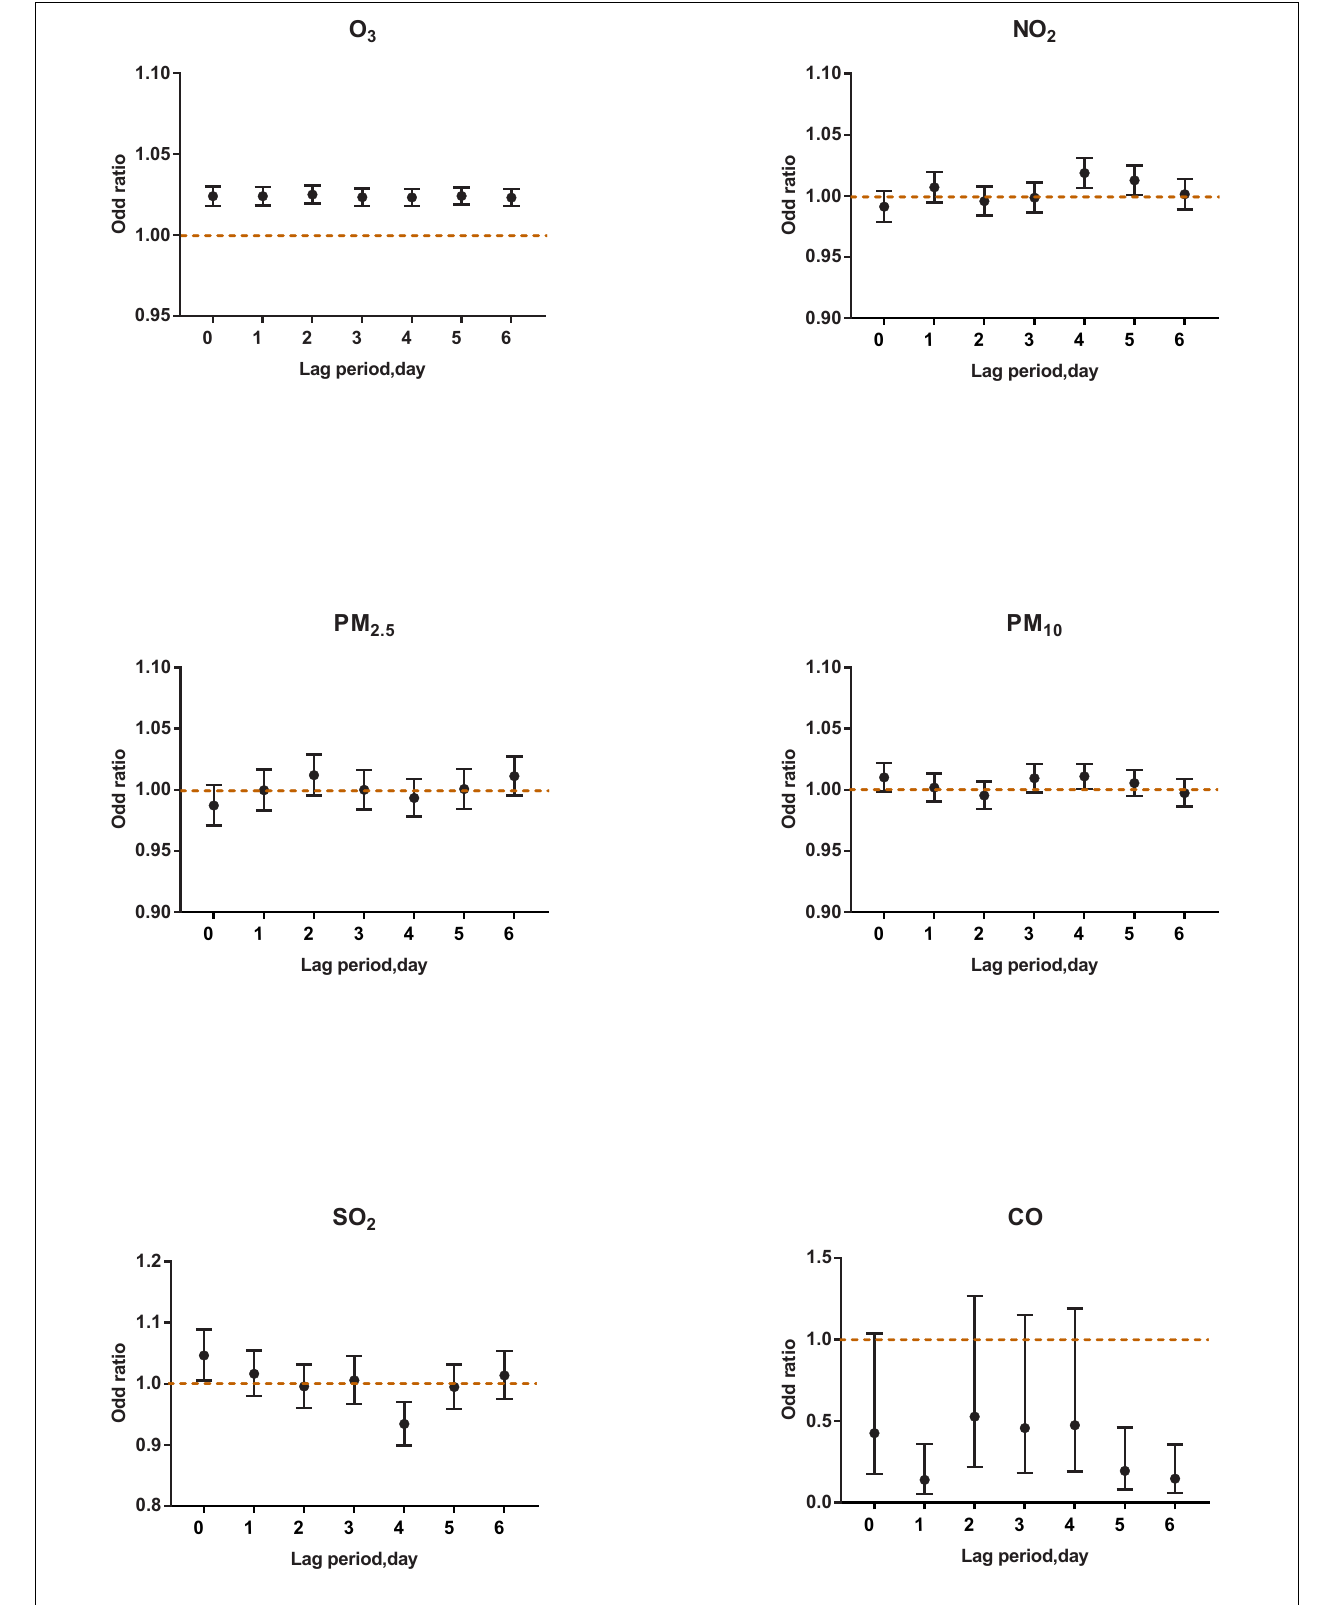
FIGURE 5 | Air pollutants in different lag periods in the multi-pollutant model when O 3 -8 h was between 80 and 99 µ g/m 3 .